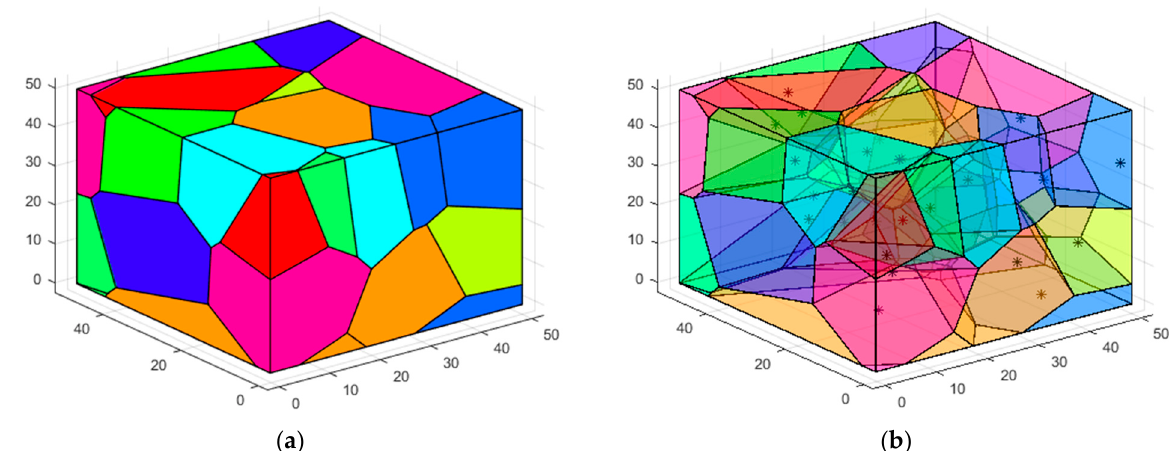
Figure 4. 3D-Voronoi partition process diagram: ( a ) Original 3D-Voronoi partition; ( b ) Display centroid 3D-Voronoi partition.